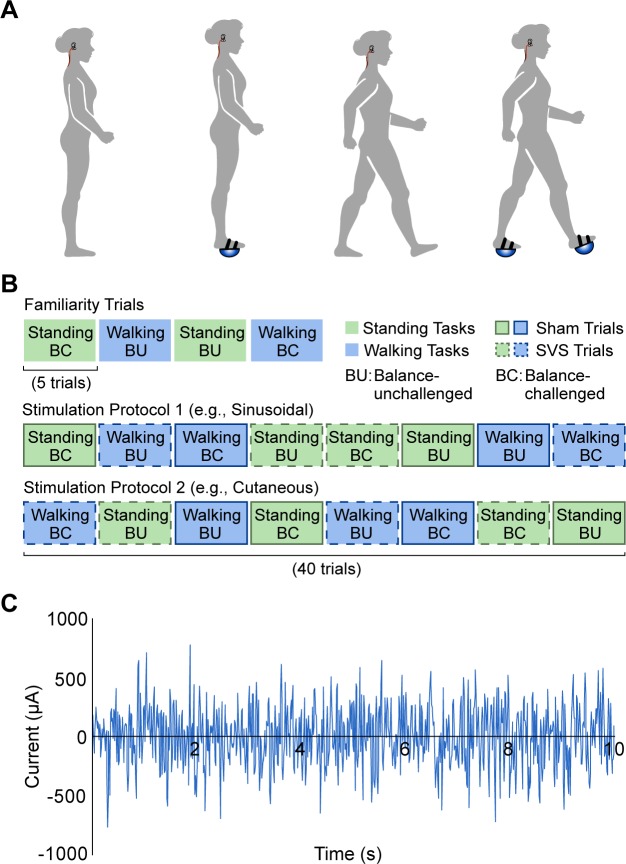
Experimental details.(A) Illustrations of the different conditions: standing with and without the balance-challenging inflatable rubber hemispheres attached to the shoes; walking with and without the balance-challenging inflatable rubber hemispheres attached to the shoes. (B) An example of the experimental protocol for one participant. We randomized the blocks of trials within each stimulation protocol. (C) An example of the zero mean, 0–30 Hz white-noise stimulation applied in the stochastic vestibular stimulation (SVS) blocks of trials.